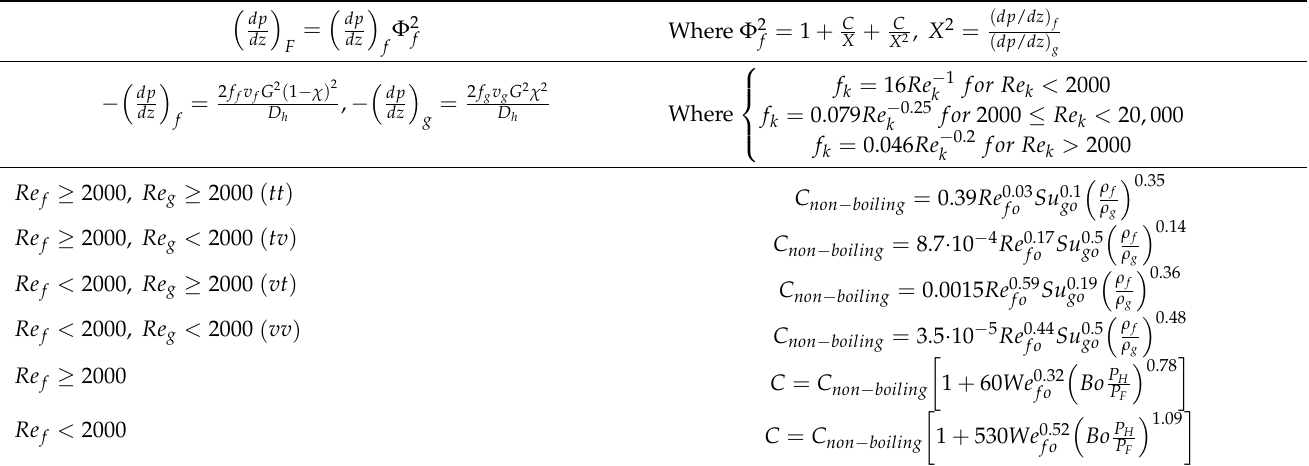
Table 5. Correlations for pressure drop in boiling mini/micro channels